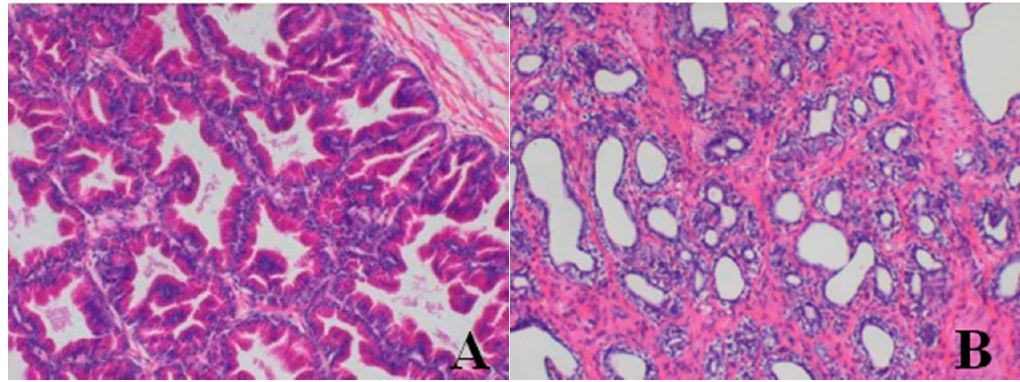
Figure 6. Hematoxylin and eosin-stained histologic sections of dogs’ epididymis ( A – C ) (original